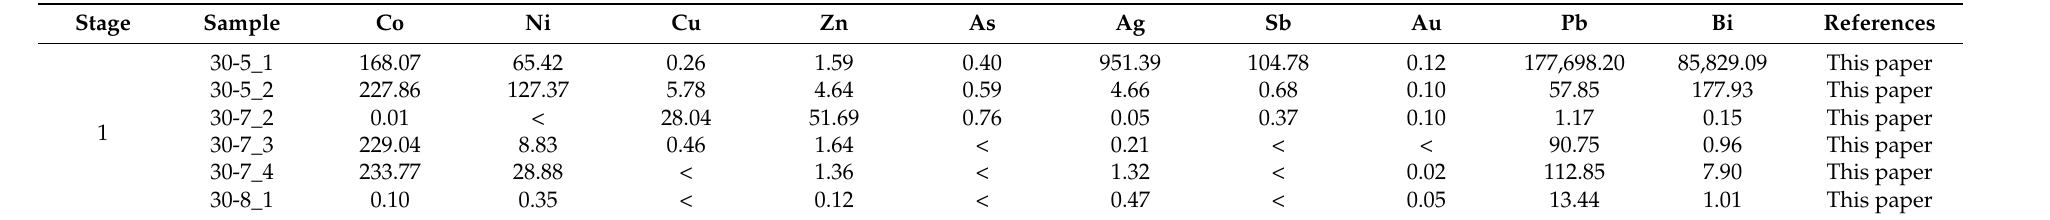
Table 2. LA-ICP-MS spot analysis data of Py1 to